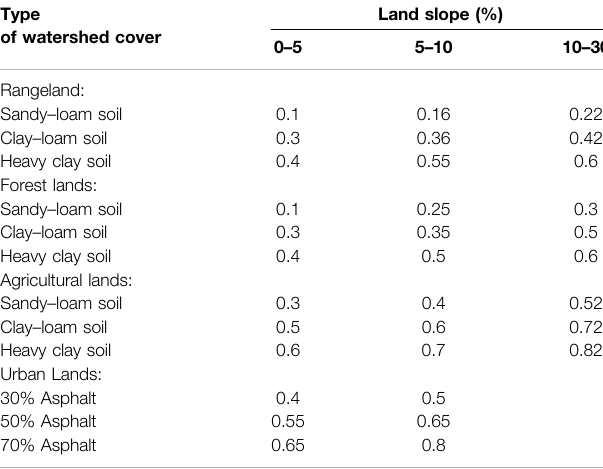
TABLE 3 | Runoff coef fi cients for different watersheds.